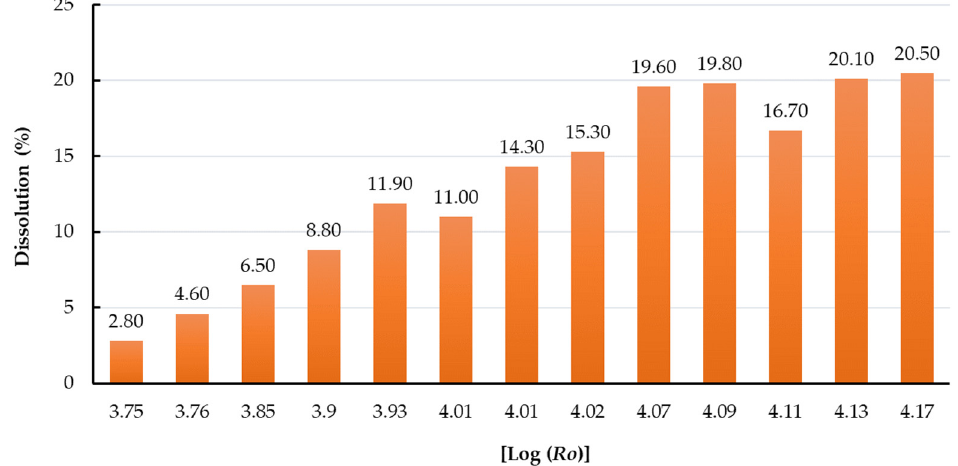
Figure 2. Effect of the severity of the pretreatment [log( R o )] on the percentage of biomass